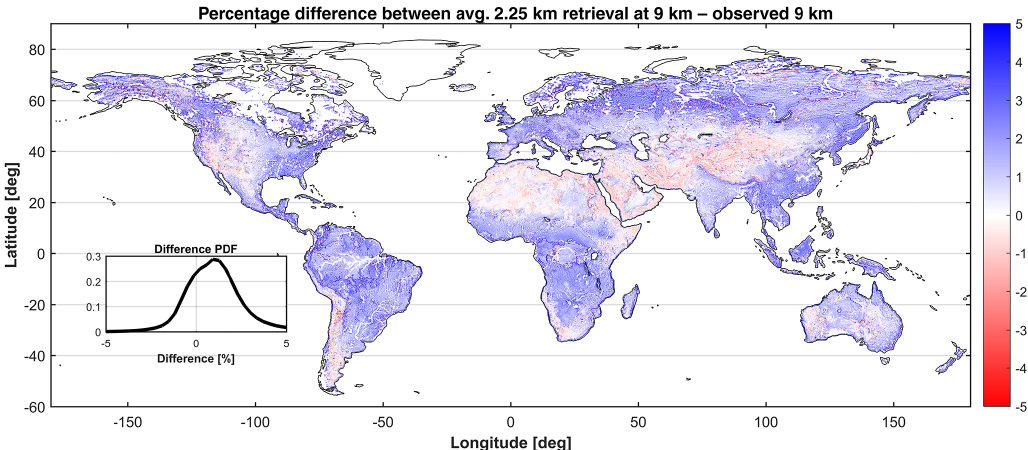
Figure 8. Percentage difference with respect to mean of average 2.25km soil moisture estimates at 9km and observed 9km soil moisture.